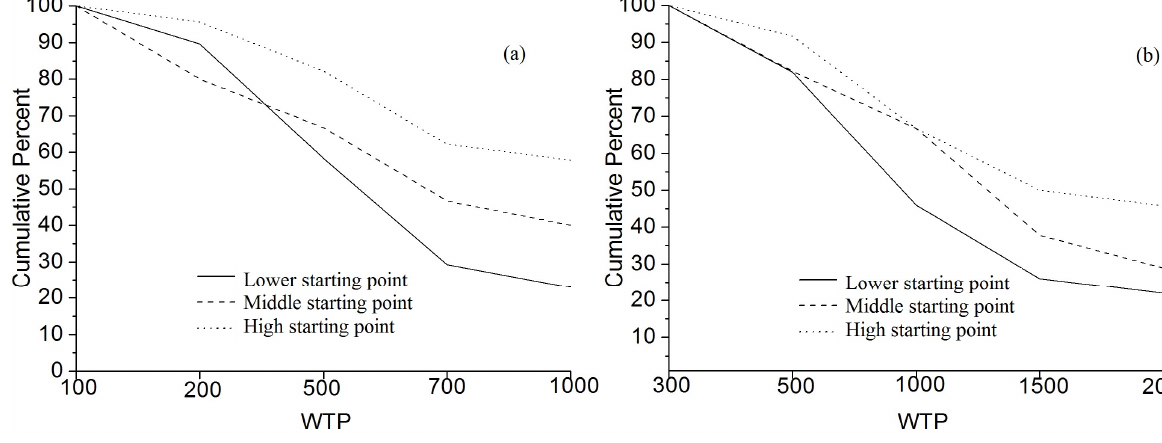
Figure 4. Cumulative distribution of maximum WTP (KZT) for standpipe ( a ) and private ( b )